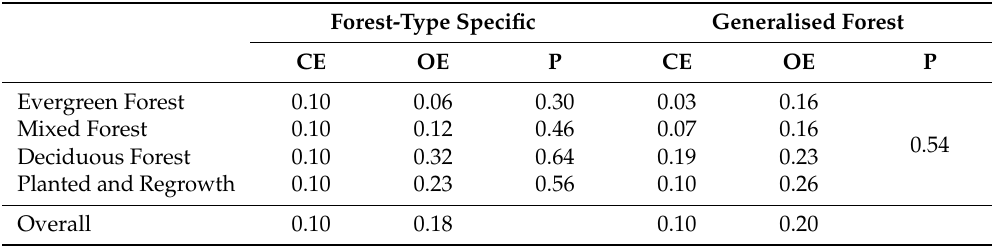
Table D1. Forest clearance commission errors (CE) and omission errors (OE) for different forest types using forest-type specific models and the generalized forest model. The example presented chooses probability thresholds (P) with the goal of attaining a commission error of 0.10 . Data for the table are illustrated in Figures 5 and 6 in the main article. Errors and probabilities are rounded to two decimal places.